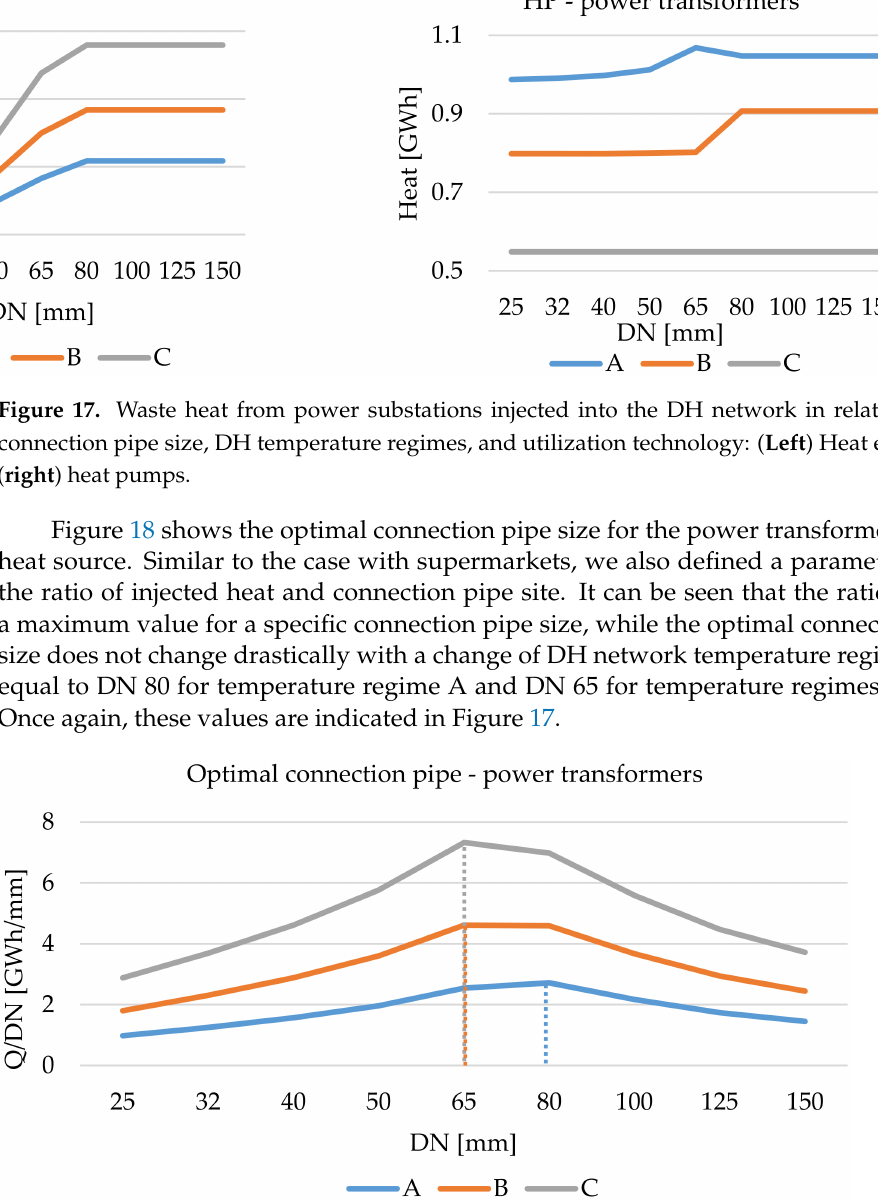
Figure 18. Optimal DH network connection pipe for power substation waste heat utilization in relation to different DH network temperature